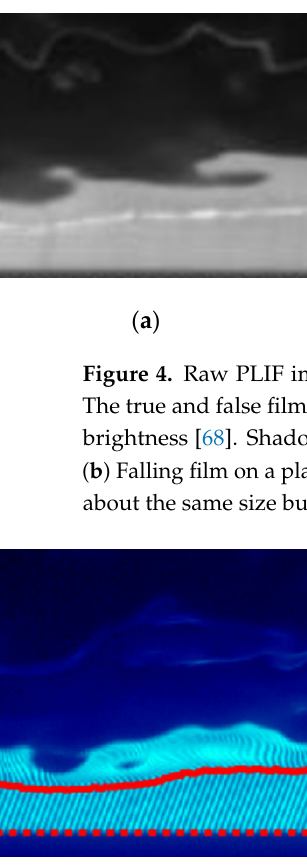
Figure 5. Identification of the true interface by the breaking shadows cast by the structuring grid at the true interface, thick falling film in a vertical circular pipe [70].